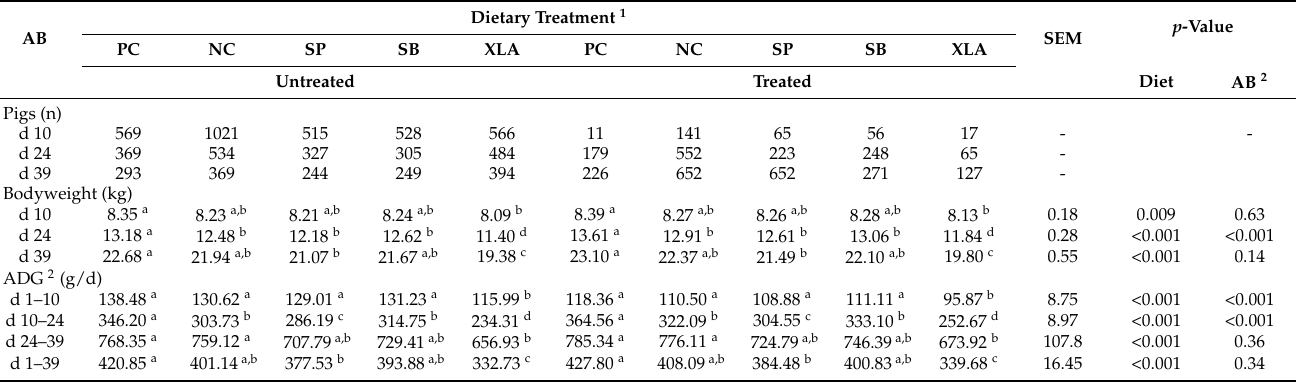
Table 4. Mean bodyweight and daily weight gain in the dietary groups of the antibiotics (AB)-treated and untreated pigs.